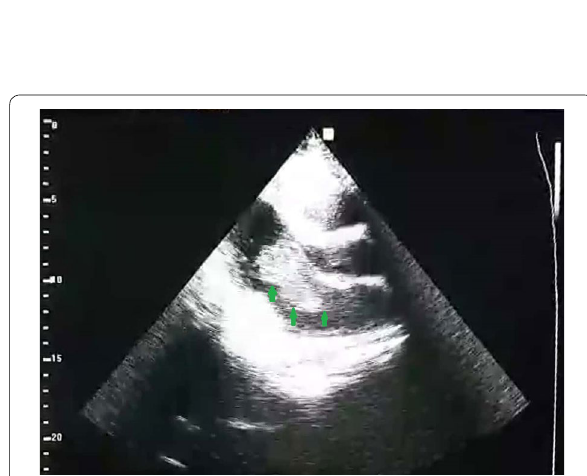
Fig. 2 The highly mobile mass floating into the left ventricle during the diastolic phase (showed by